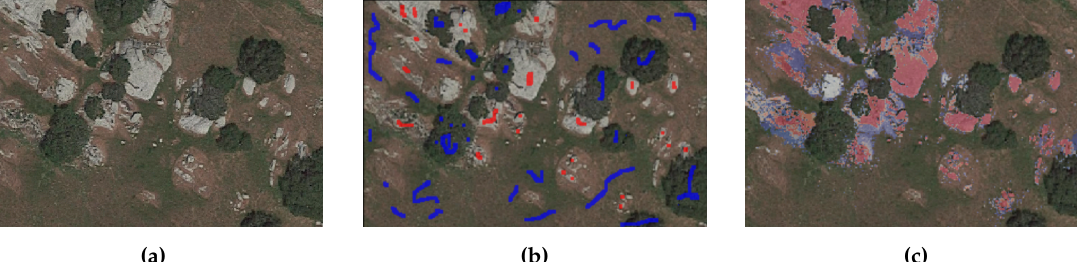
Figure 6. Illustration of KNN-process for label refinement. ( a ) NAIP imagery from ELD2; ( b ) sparse input mapping for KNN process, showing a subset of bare rock pixels classified in red and other pixel examples marked in blue; ( c ) KNN propagated final label classifications, with bare rock in red and other shown as transparent for clarity.